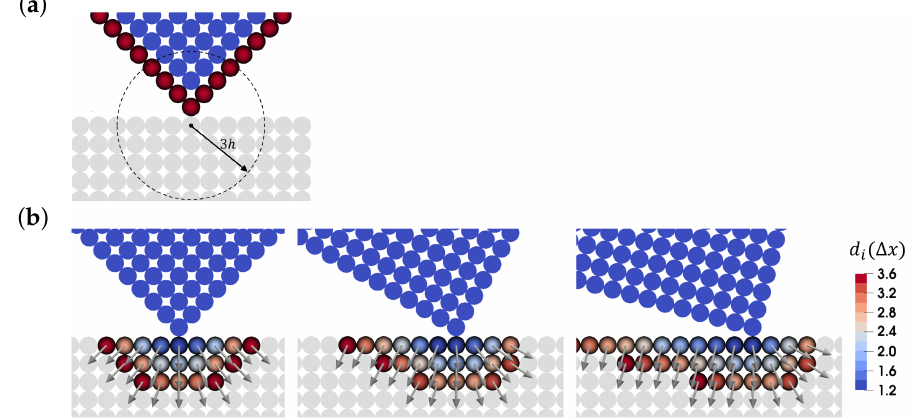
Figure 1. Contact of two solid bodies, where the top one is the primary body and the bottom one is the secondary one. SPH particles are located at the centers of the circles. The circles diameter is the same as ∆ x that is the particle spacing. ( a ) Boundary particles of the primary surface (red particles) that contribute to the contact calculations of the marked secondary particle with the depicted supporting domain. ( b ) Distance d i and normal vector (cid:126) n i for the secondary